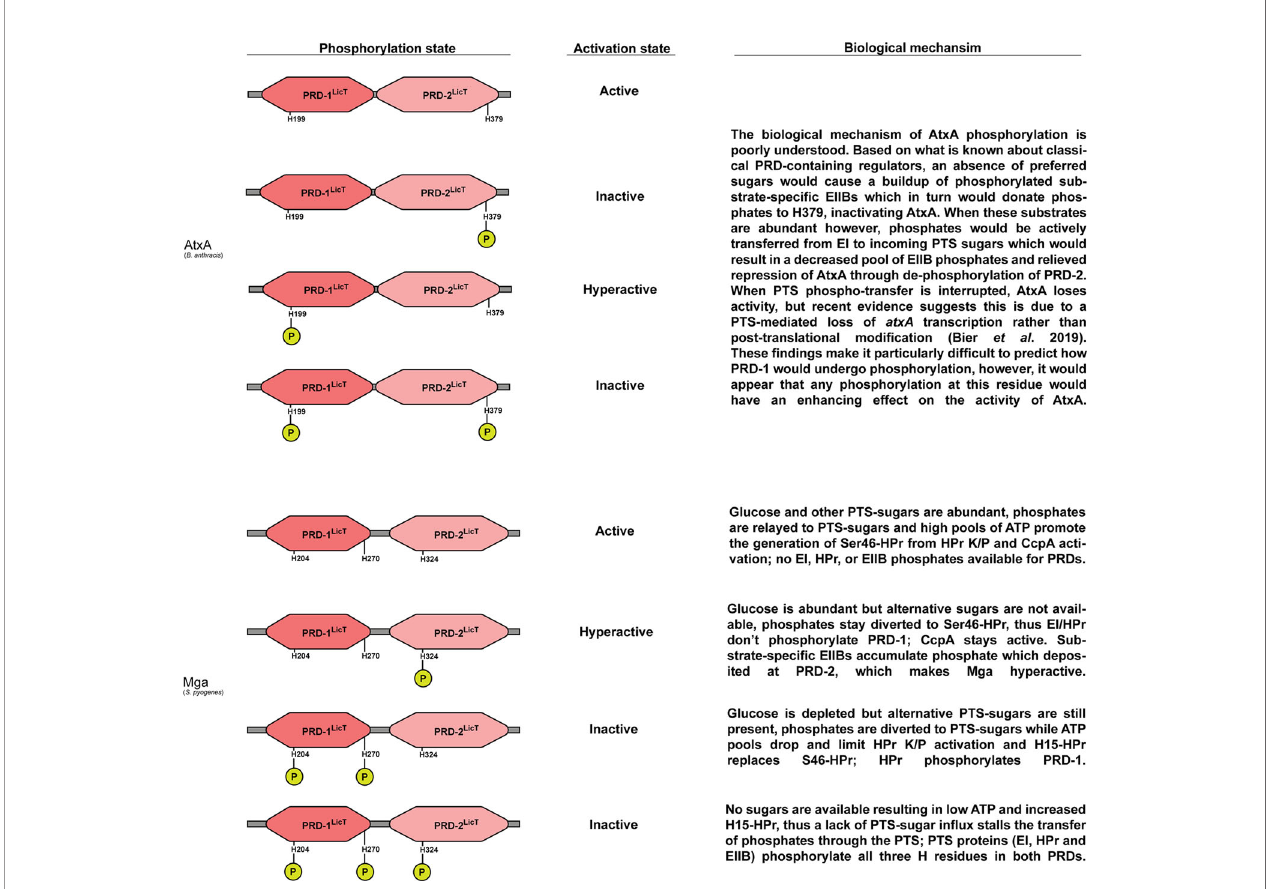
FIGURE 3 | Functional status and hypothesized biochemical inputs that regulate AtxA and Mga PRDs. Left: Predicted phosphorylation patterns for PRDs contained within AtxA and Mga. Center: Resulting activity levels given respective phosphorylation patterns; note that phosphorylation at the PRD2 has a dominant role on PCVR activation in AtxA whereas phosphorylation in PRD1 dominates the activation state of Mga. Right: Predicted biological inputs resulting in respective phosphorylation and PCVR activation